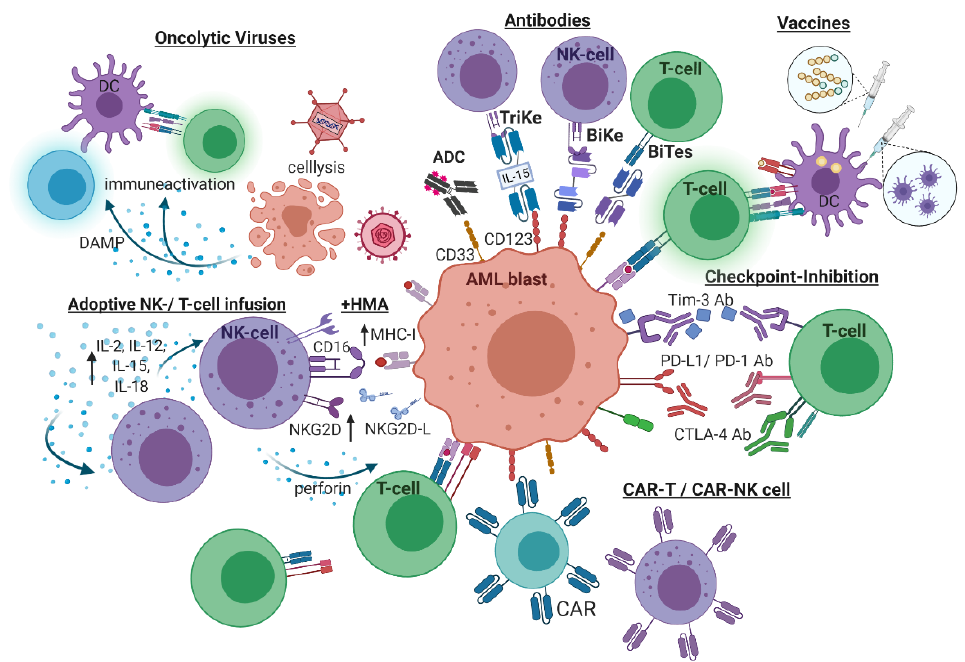
Figure 2. Immunotherapeutic approaches in AML. Checkpoint blockade prevents immune-suppressive signaling through programmed cell-death protein-1/programmed cell-death ligand (PD-1/PD-L1), cytotoxic T-lymphocyte associated pro- tein 4 (CTLA-4), T-cells immunoglobulin-mucin 3 (Tim-3)/galactin-9 (Gal-9), as prominent examples. Cellular-based immunotherapeutic approaches comprise adoptive T- and NK cell infusion. Exposure to activating cytokines (IL-2, -12, -15, and -18) augments NK-mediated cytotoxicity. Additional administration of hypomethylating agents (HMA) potentiate cellular immune response. Chimeric antigen receptor (CAR) is another strategy to improve leukemia directed T- and NK cell reactivity. Leukemia-associated antigen-directed antibodies stimulate antibody-dependent cell-mediated cytotoxicity (ADCC). Antibody–drug conjugates (ADC) are linked to cytotoxic agents to directly lyse targeted leukemic blasts. Bispecific T-cell engager (BiTE), bi- and tri-specific NK cell engager (BiKE, TriKE) bind and crosslink leukemic antigens to T- and NK cells facilitating anti-leukemic reactivity. Vaccine therapy can be either based on antigens or dendritic cells, presenting neoantigens to T-cells resulting in leukemia-directed cytotoxicity. Oncolytic viruses directly lyse infected AML cells and specifically reinforce anti-leukemic immunogenicity, i.e., through released specific damage-associated molecular patterns (DAMP). Figure 2 was created with with biorender.com (accessed on 20 February 2021).